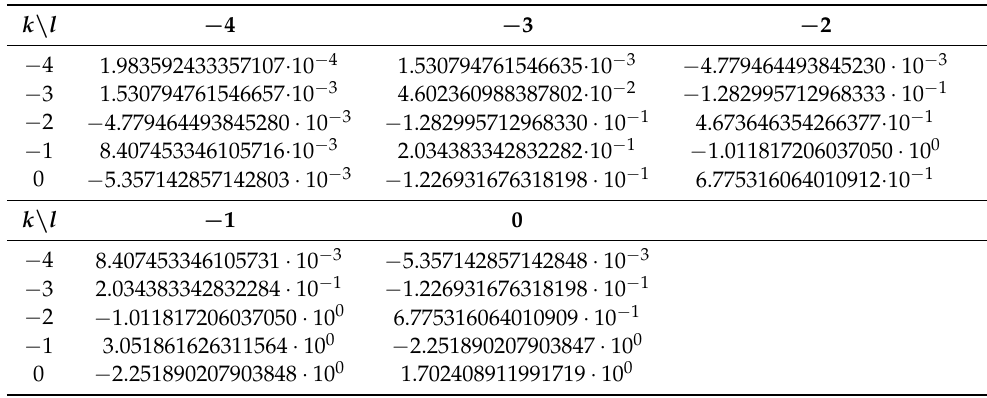
; [ 0,1 ]) evaluated up to machine ( 3,2 )